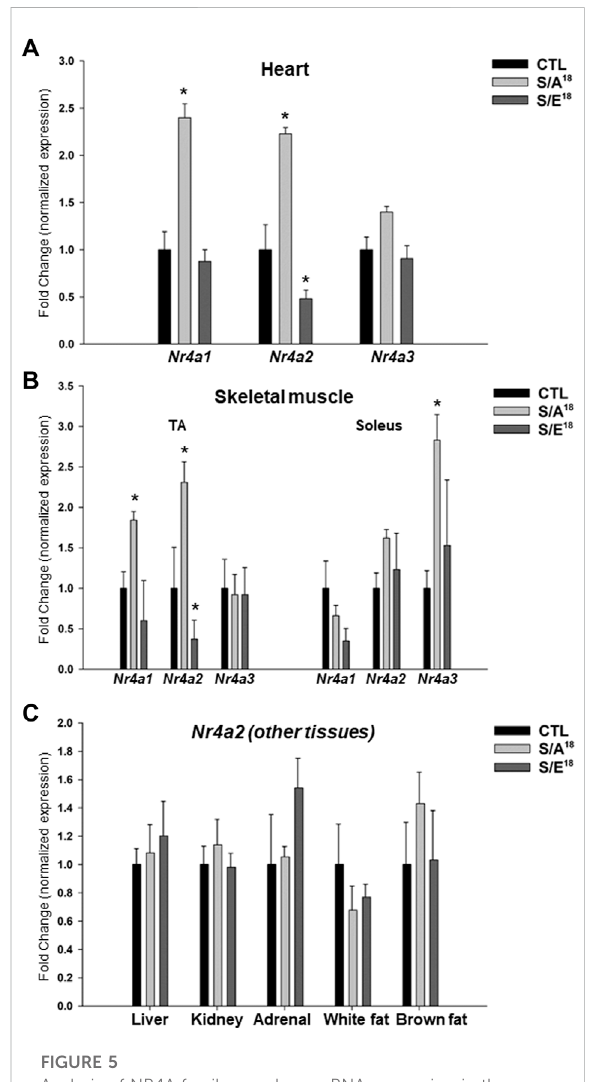
heart,skeletalmuscles,andotherorgansinpeptidetreatedmiceat 4.5 mg/kg/day dose. (A) . Nr4a1,2,3 subgroup mRNA expression in the heart. (B) . Nr4a1,2,3 subgroup mRNA expression in the tibialis anterior (TA) and soleus (Sol) muscles(* p < 0.05 vs.CTL, n = 5). (C) . Nr4a2 mRNA expression in other tissues in peptide treated mice at 4.5 mg/kg/day dose.